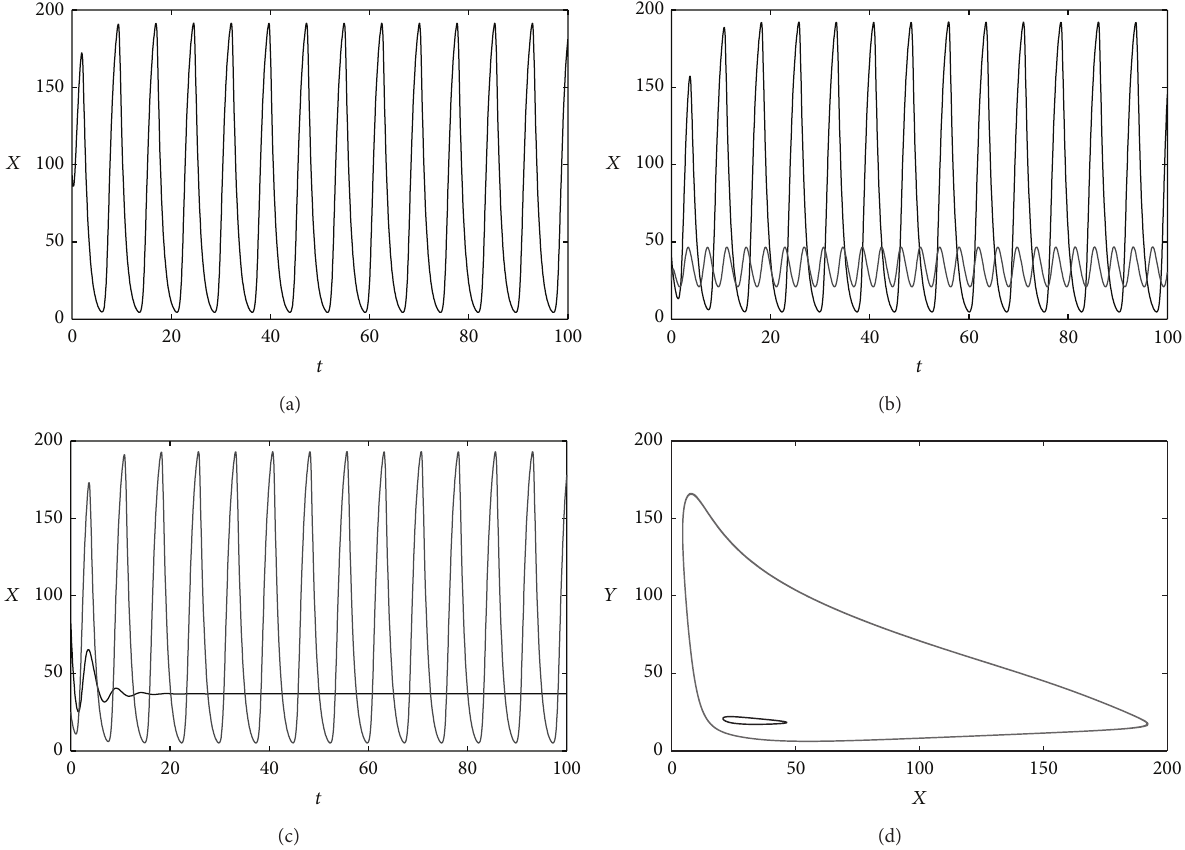
Figure 3: Typical time courses of state variable 𝑋 for the five parameter ranges (from left to right): (a) 𝛼 = 14 , single limit cycle oscillation for initial values 𝑋(0) = 95 , 𝑌(0) = 96 , 𝑍(0) = 15 , and 𝑆(0) = 97 ; (b) 𝛼 = 15.5 , birhythmicity, coexistence of two regimes of sustained oscillations corresponding to the large for initial values 𝑋(0) = 42 , 𝑌(0) = 91 , 𝑍(0) = 79 , and 𝑆(0) = 95 and small amplitude periodic orbits for initial values 𝑋(0) = 25 , 𝑌(0) = 16 , 𝑍(0) = 11 , and 𝑆(0) = 49 ; (c) 𝛼 = 18 , hard excitation, coexistence of two regimes of stable steady state for initial values 𝑋(0) = 85 , 𝑌(0) = 34 , 𝑍(0) = 58 , and 𝑆(0) = 22 and sustained oscillation for initial values 𝑋(0) = 25 , 𝑌(0) = 34 , 𝑍(0) = 58 , and 𝑆(0) = 22 ; (d) phase diagram of the state variables 𝑋 and 𝑌 with the same parameter values and initial values in panel (b).